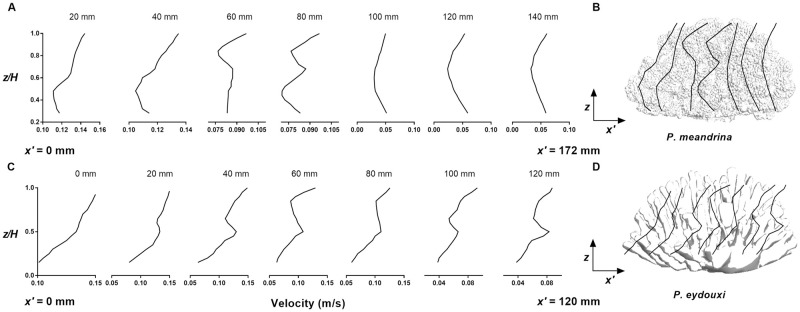
Streamwise variation of the mean streamwise velocity profile in P. meandrina.(A and C) Mean streamwise velocity profiles in the P. meandrina and P. eydouxi colonies, respectively, as a function of normalized height at 20-mm intervals along the length of the colony. The profiles were obtained by averaging the velocity magnitudes of the closest 10 neighboring grid points at each location in the x-z planes, and then averaging the velocity magnitudes over the lateral (y) direction within the colonies. (B and D) Schematic of the locations of the mean velocity profiles within the coral colonies (not to scale).